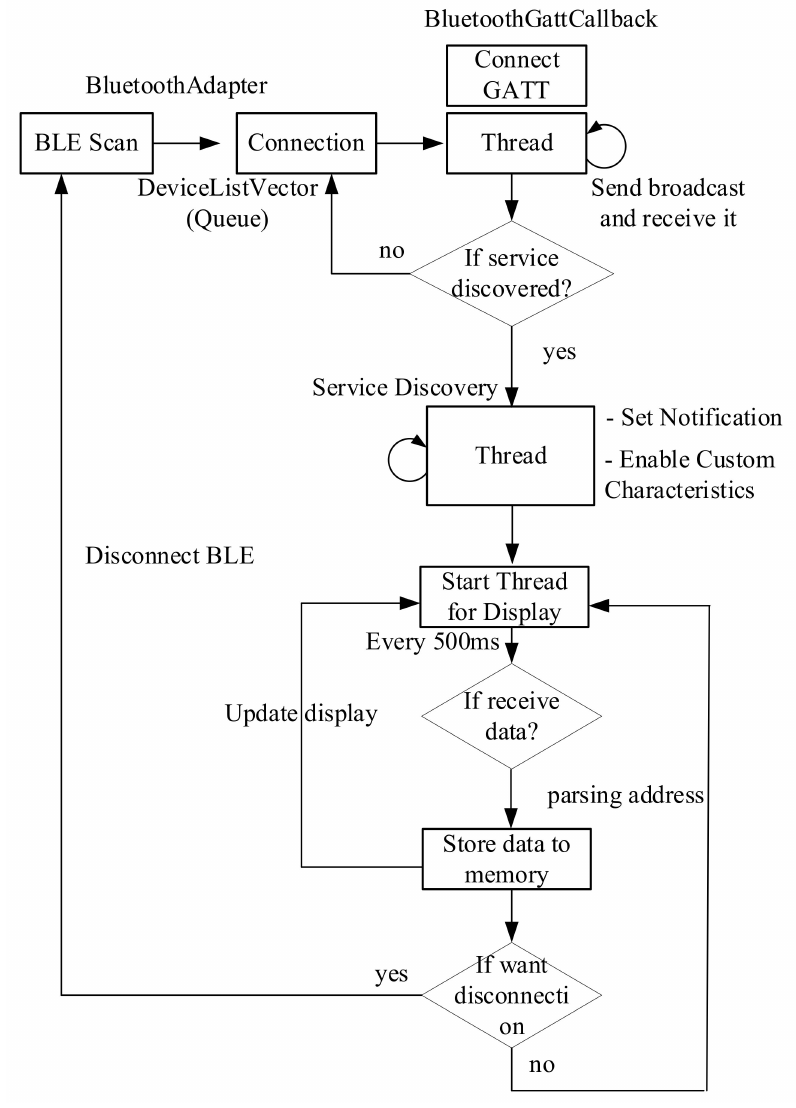
Figure 12. Android architecture for the PM sensing